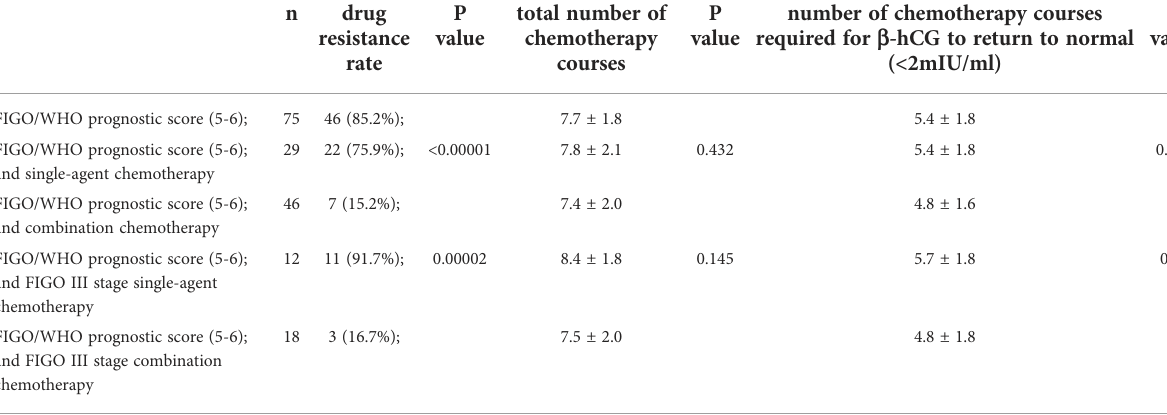
FIGO, International Federation of Gynecology and Obstetrics; WHO, World Health